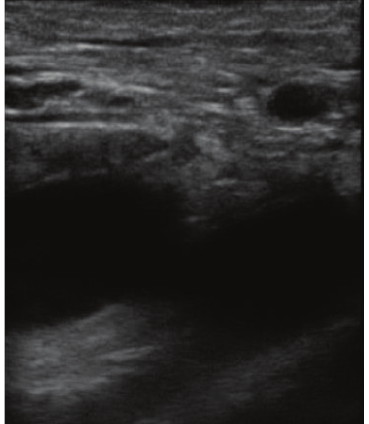
Figure 9: Follow-up image of IVC showing wide patency after removal of catheter